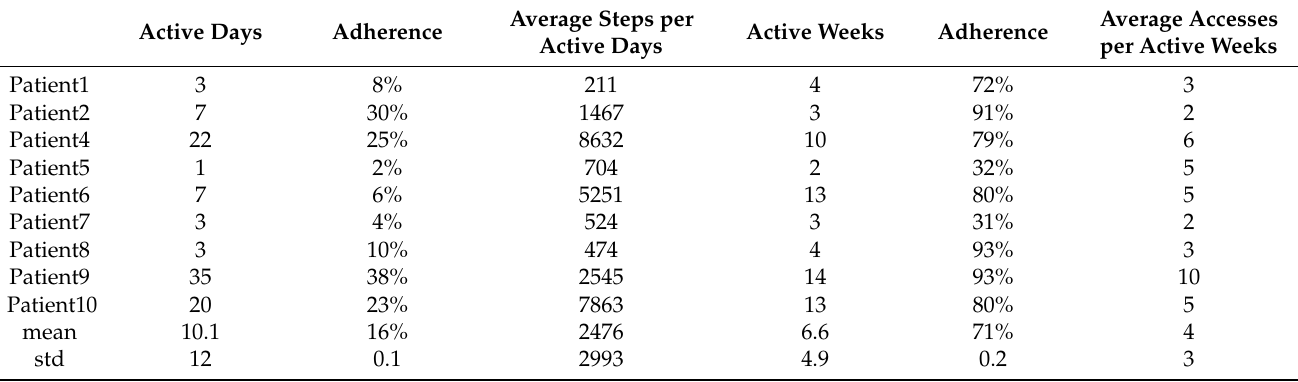
Table 7. vCare steps parameter and active weeks for the HF